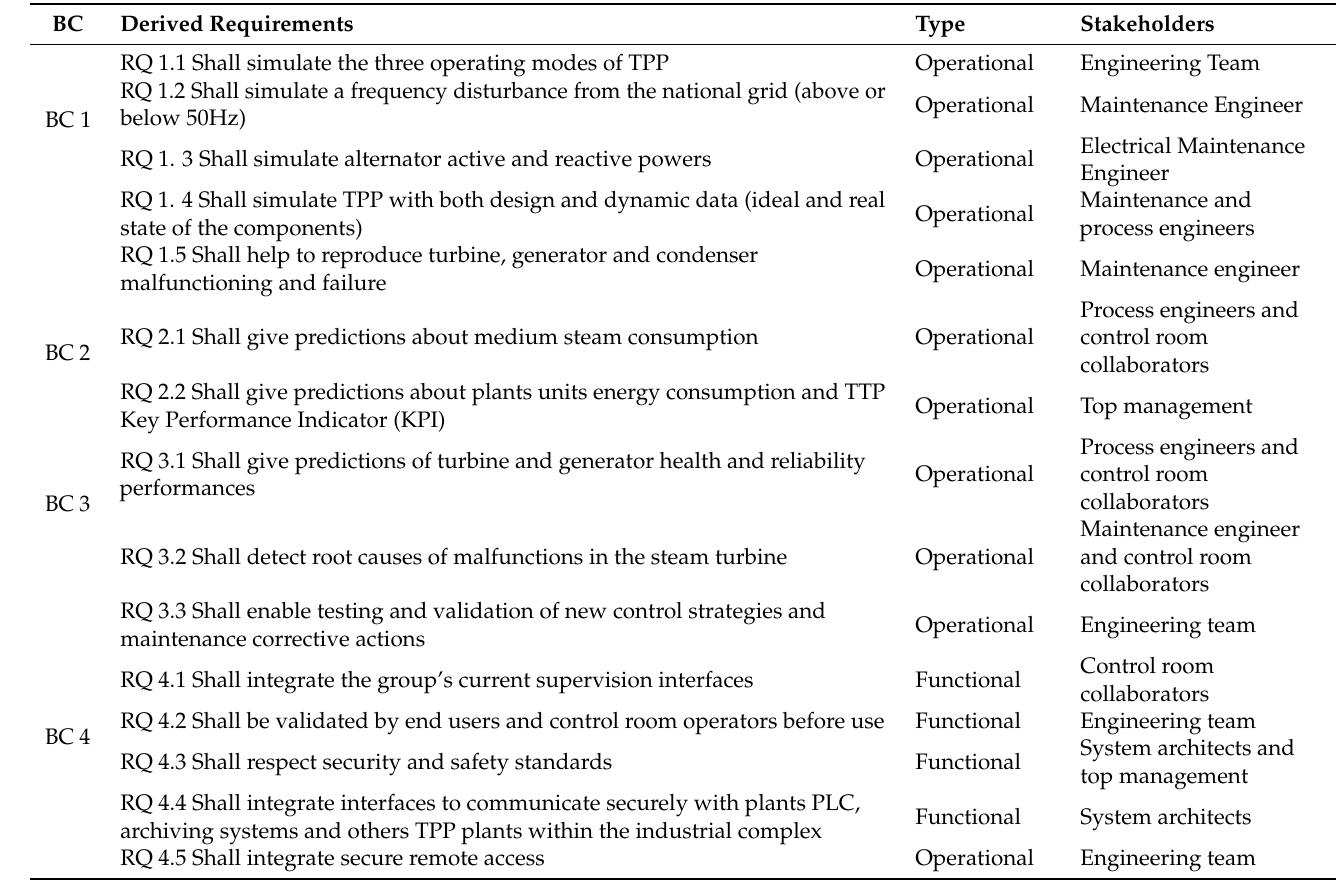
Table 2. Business concerns for HT-OMASE